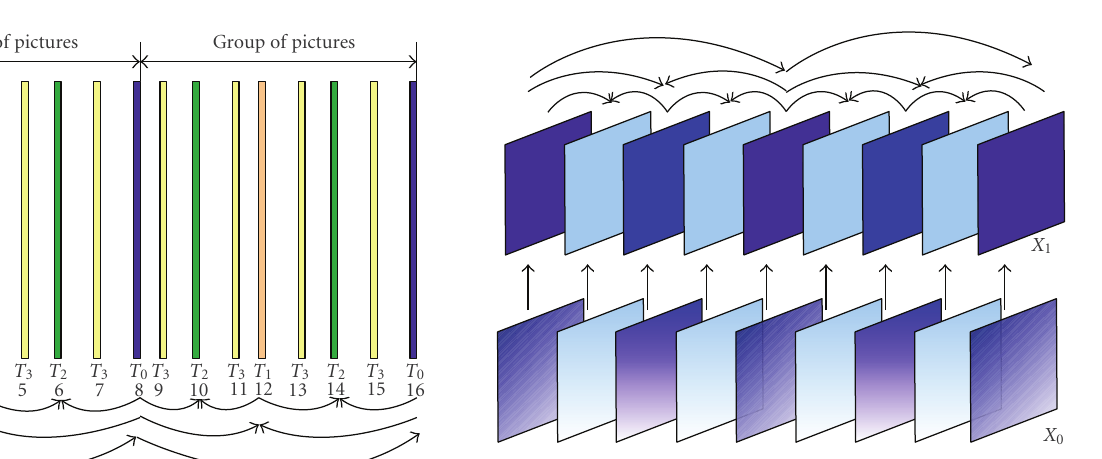
Figure 3: Temporal and quantization